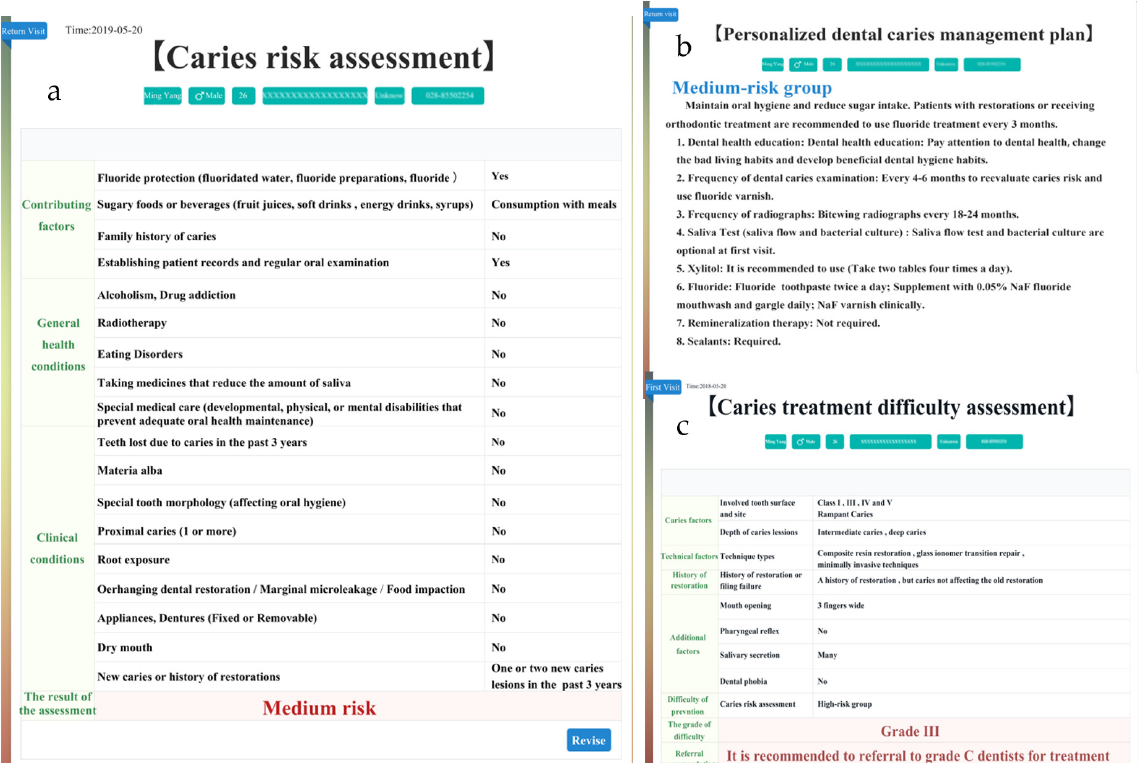
Figure 6. ( a ) Caries Risk Assessment Form of return visit; ( b ) Personalized caries management plan of return visit; ( c ) Caries treatment difficulty assessment of return visit.